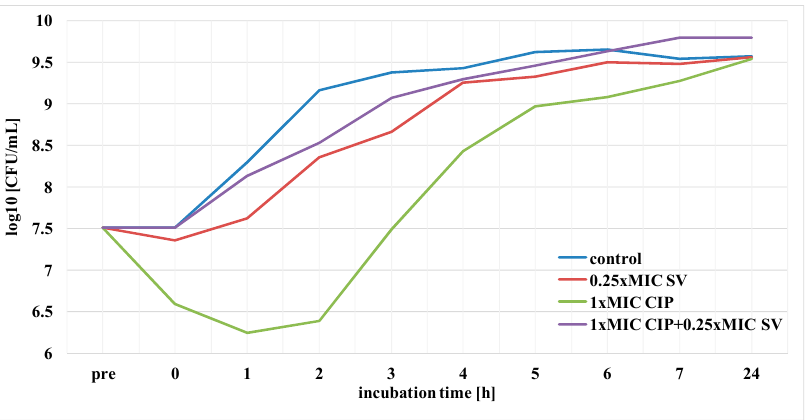
Figure 4. PAE of ciprofloxacin (CIP) against E. coli in the presence of S. virgaurea extract (SV).